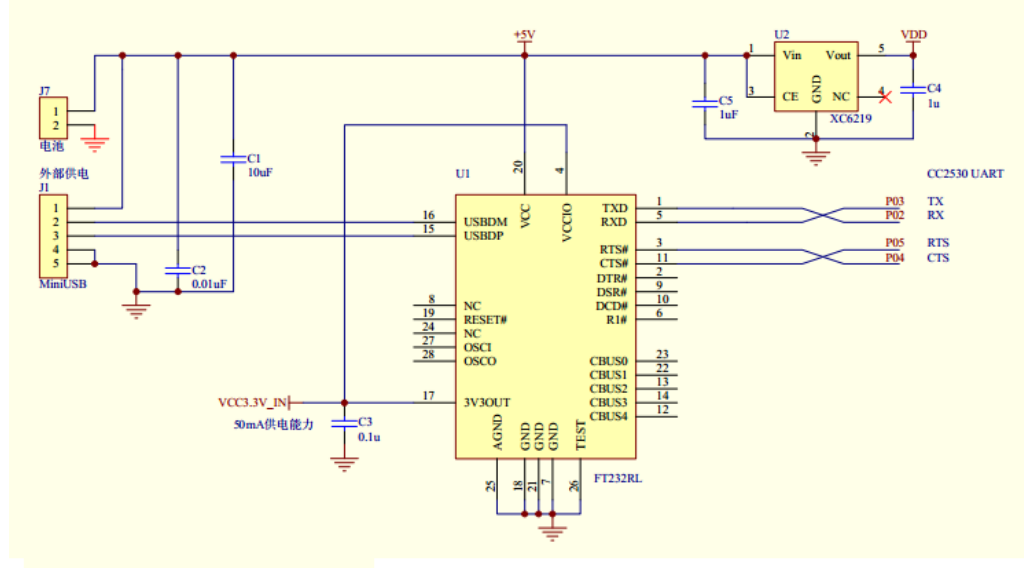
Figure 6. Schematic design of PCB.